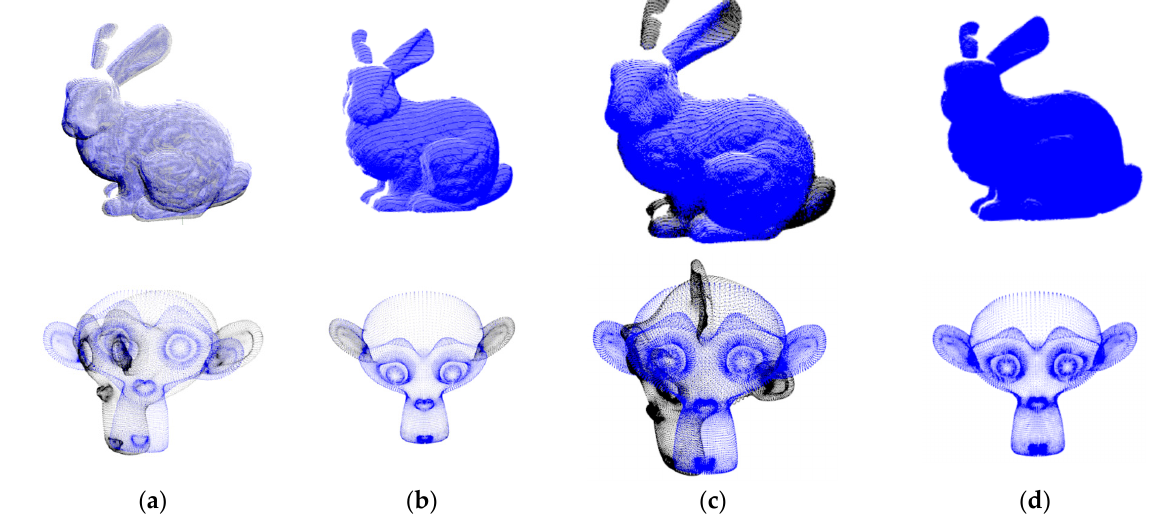
Figure 6. Registration results of Bunny and Monkey. ( a ) Standard ICP algorithm; ( b ) Standard RANSAC algorithm; ( c ) Depth Filtering ‐ ICP ; ( d ) IWOA ‐ RANSAC ‐ ICP algorithm . RANSAC algorithm; ( c ) Depth Filtering-ICP; ( d ) IWOA-RANSAC-ICP